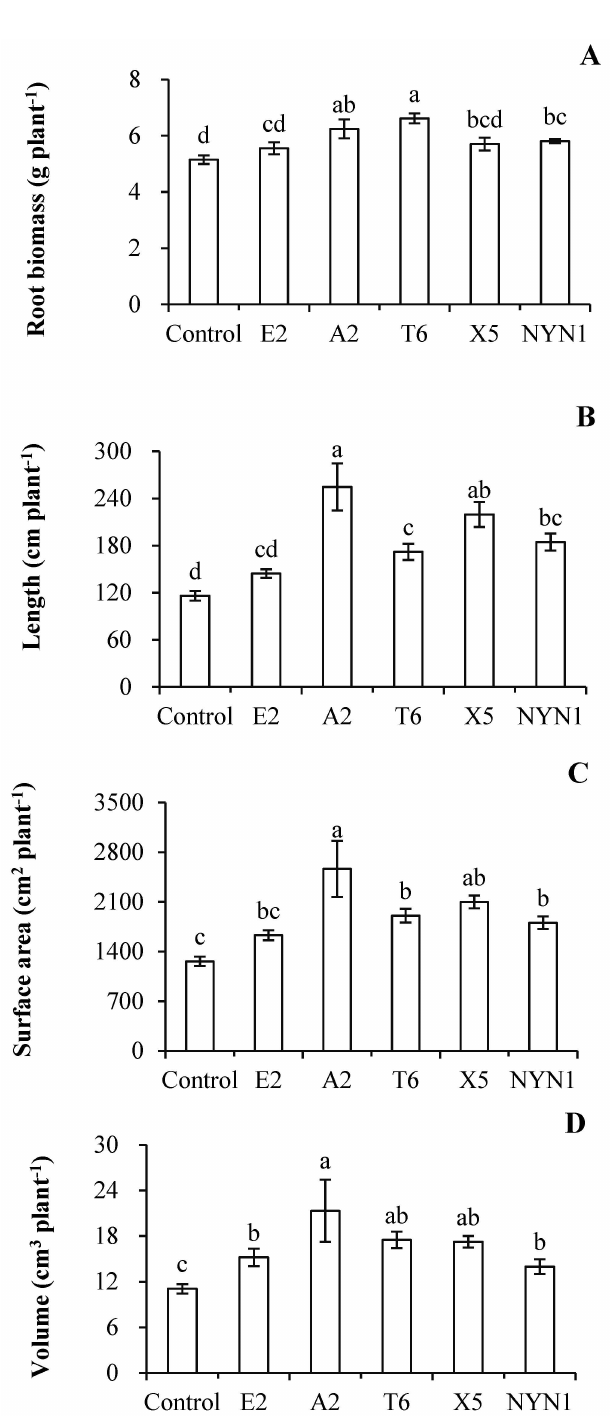
Figure 2. Effects of AMF isolates on root biomass and architecture of tomato plants. Root biomass ( A ), root total length ( B ), root surface area ( C ), and volume ( D ). Different letters indicate significant differences ( p ≤ 0.05) among the different treatments after ANOVA and LSD tests. Bars are the mean ± SE ( n = 4). F - root biomass = 6.00; F - root lengths = 10.52; F - surface areas = 6.10; F - volumes =